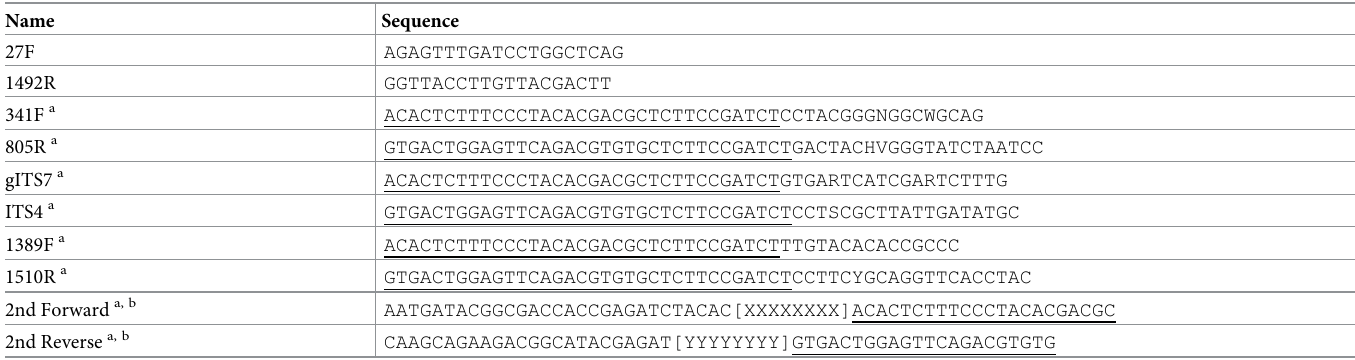
Table 1. Primers used in the